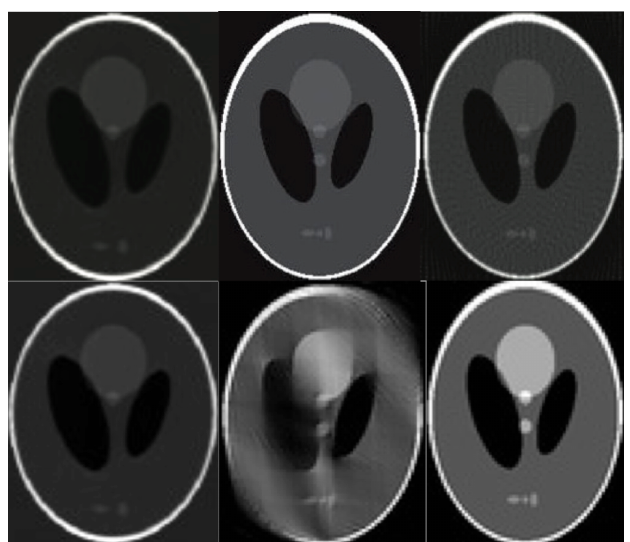
Figure 3. The Shepp–Logan phantom images based experiment results for the cases exposed in Table 1 rows numbers: 1, 2, 3. The bottom row refers to: Table 1 rows numbers: 4, 5, 6.